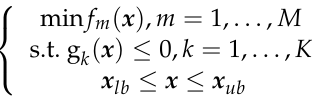
Figure 3. Flowchart of the proposed multi-objective reliability optimization method.